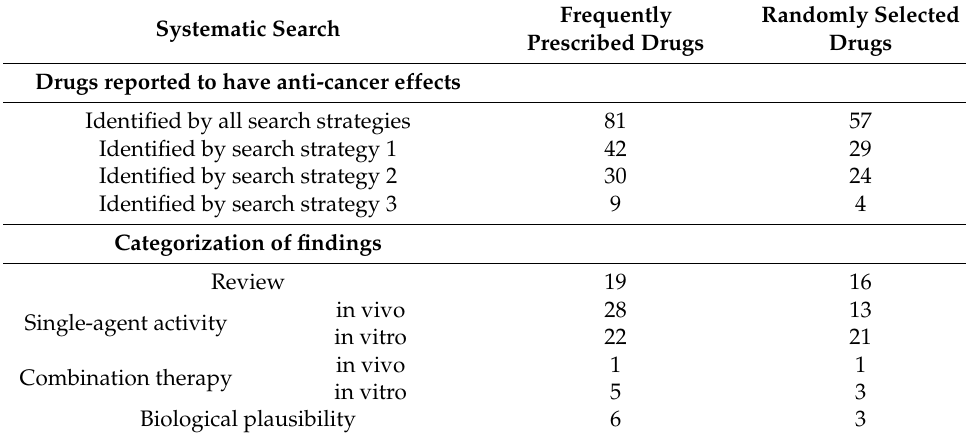
Table 1. Results of the systematic search.